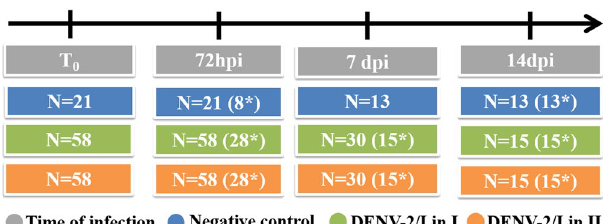
Figure 9. Number of mice used in clinical analysis at each time of infection. T 0 : before infection, hpi: hours post infection, dpi: days post infection, (*) mice euthanized at that time of infection, Lin: Lineage.